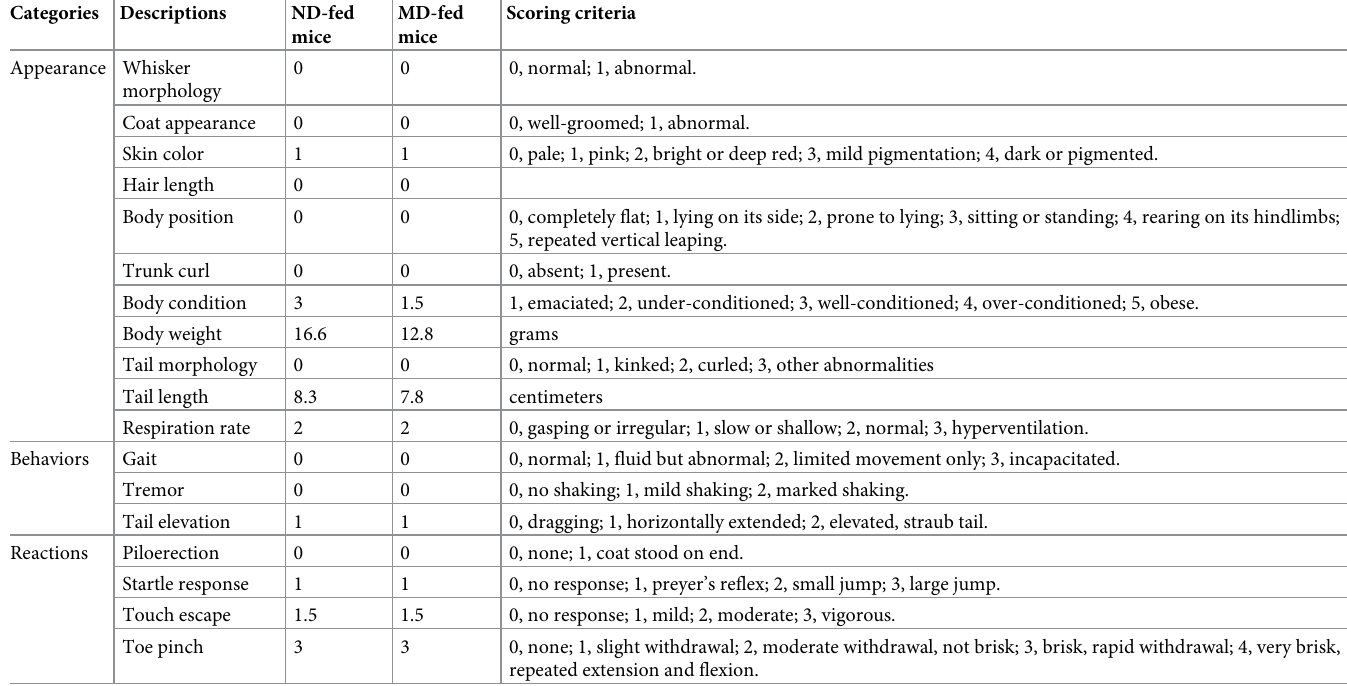
Table 2. SHIRPA of 5 week-old F2 mice fed with normal and malnourished isocaloric diets, related to Fig 2 (n = 6). Categories